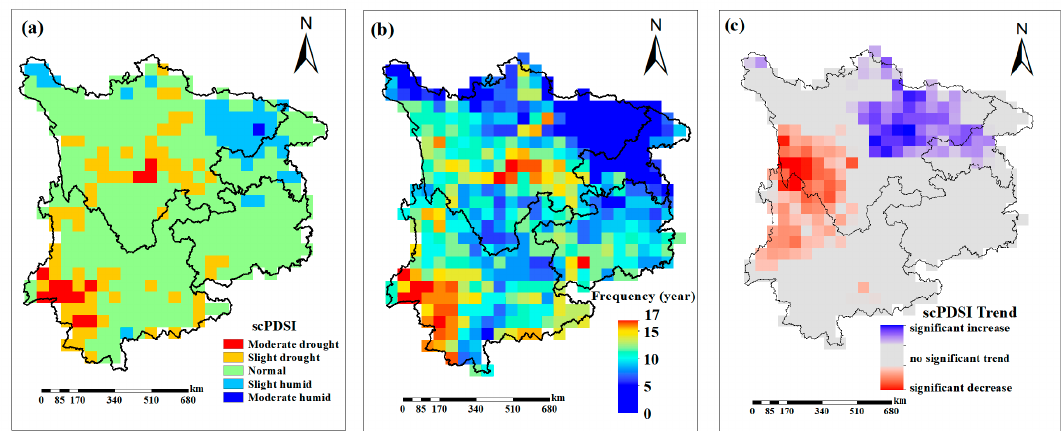
Figure 3. The spatial distribution, frequency, and trend of drought as measured by scPDSI in Southwest China over the period 2000–2017: ( a ) the spatial distribution of the long-term mean scPDSI; ( b ) the frequency map of drought occurrence; ( c ) the scPDSI trend.